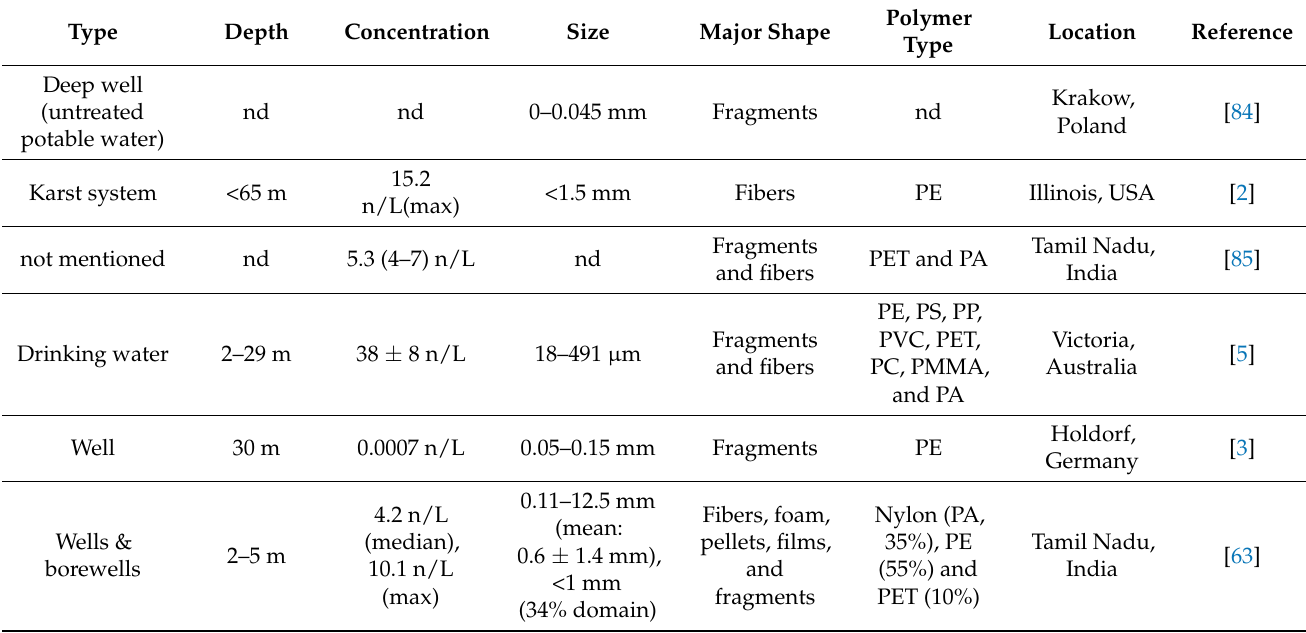
Table 2. Typical occurrences and phenomenon of microplastic contamination in groundwater (Adapted from (Huang et al.,